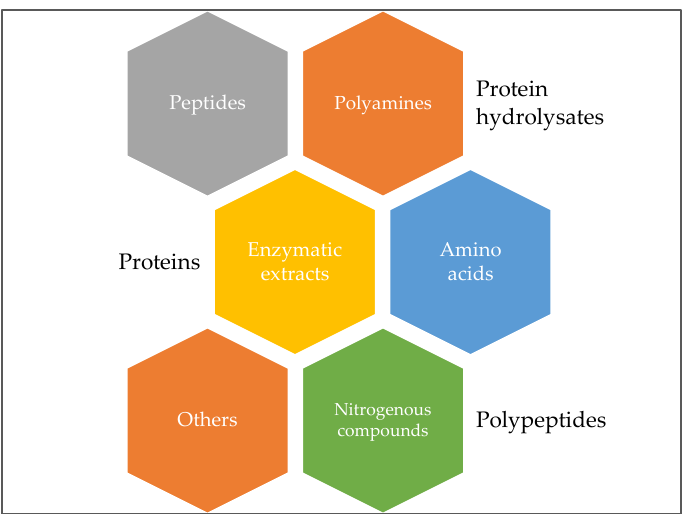
Figure 1. Possible active ingredients in protein-based biostimulants (PBBs). Compounds in white and black are large molecules, while active ingredients in colored hexagons are low molecular weight components of proteins [27].